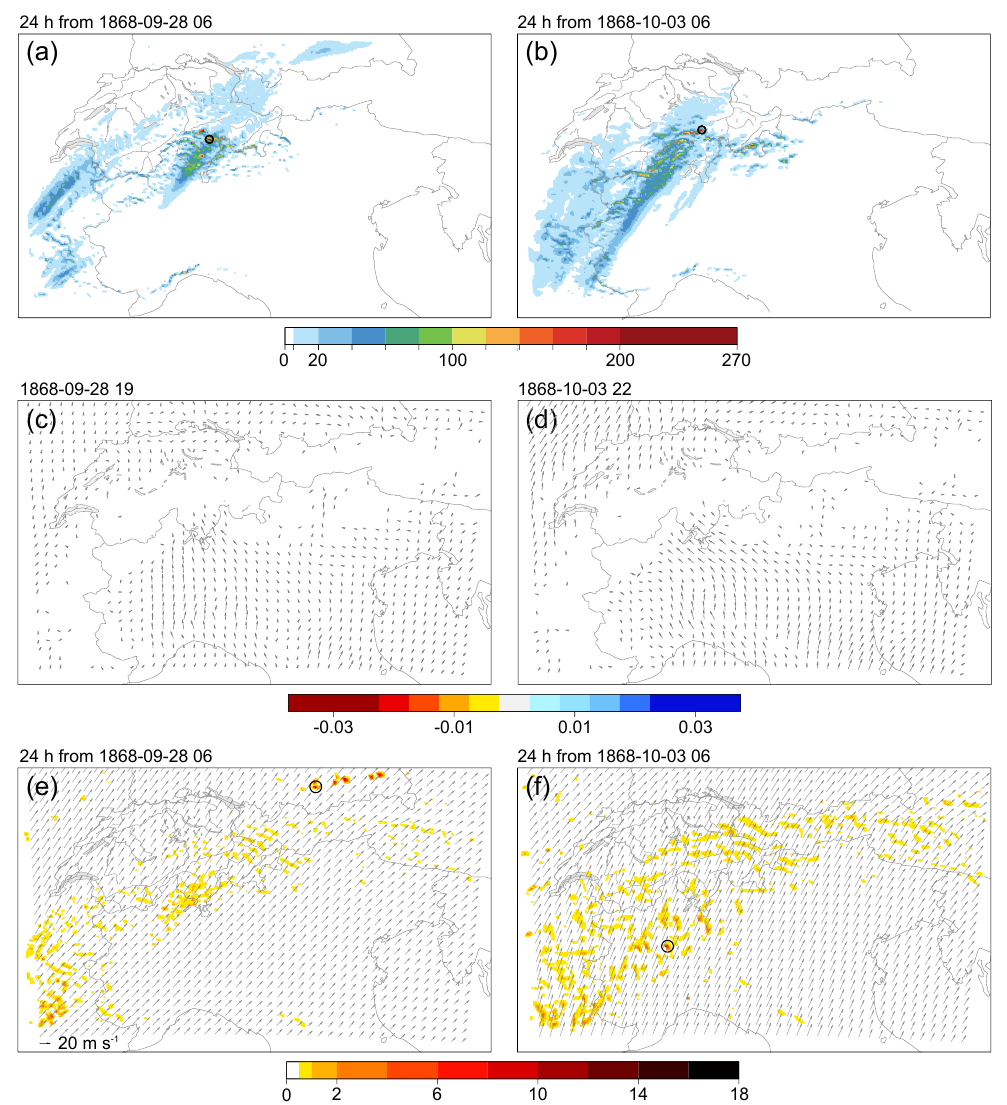
Figure 9. Weather variables for 28 September 1868 (a, c, e) and 3 October 1868 (b, d, f) as simulated in the innermost WRF model domain. (a, b) Cumulated precipitation (mm24h − 1 ; shade) starting at 06:00UTC. Orography is shown above 1000ma.s.l. (c, d) Moisture flux divergence (gkg − 1 s − 1 ; shade; negative values indicate flow convergence) and transport (ms − 1 kgkg − 1 ; vectors) at 900hPa at two specific time steps. (e, f) Mean vertical wind (uplift w ; ms − 1 ) and mean horizontal wind speed at 600hPa over 24h starting at 06:00UTC. Circles mark the grid cells with the highest